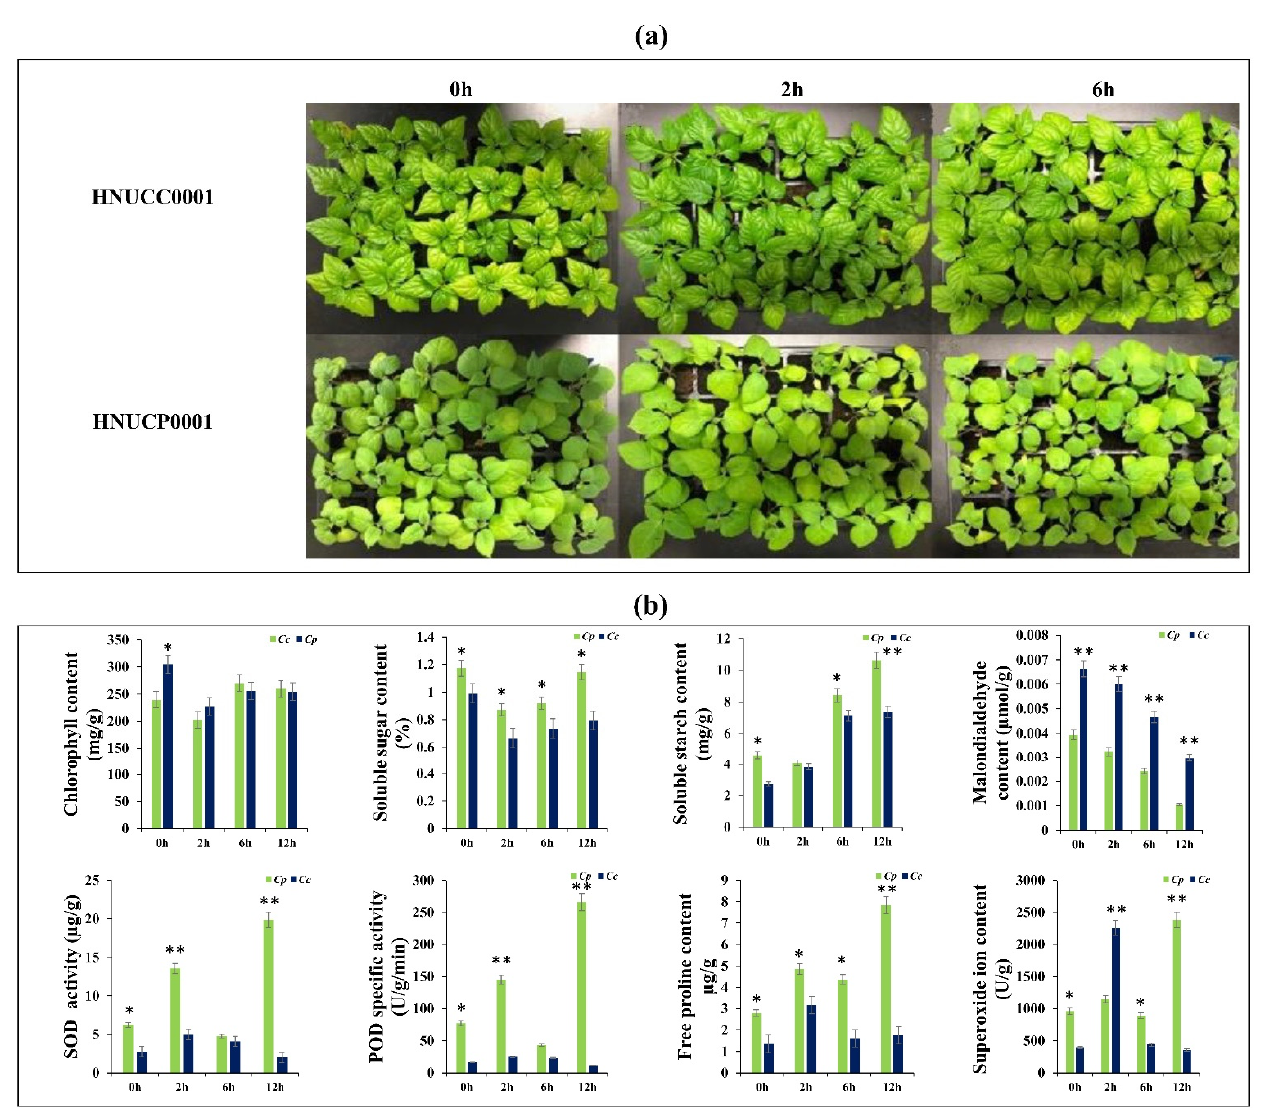
Figure 1. ( a ) Phenotypic representation of the C. pubescens and C. chinense pepper plants subjected to cold stress at different time points. ( b ) Response of morphological and biochemical indexes of the C. pubescens and C. chinense pepper plants subjected to cold stress at different time points. Data represent means ± S.E. of three replicates. Asterisks indicate significant differences (* p > 0.05, ** p > 0.01, Student’s t -test).